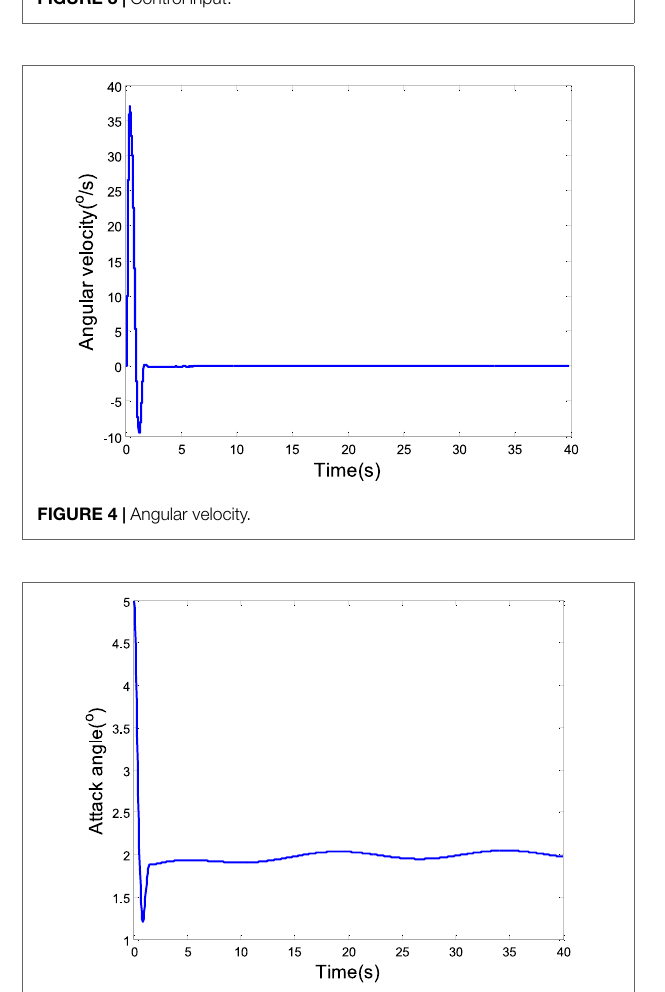
FIGURE 5 | Tracking attack angle.